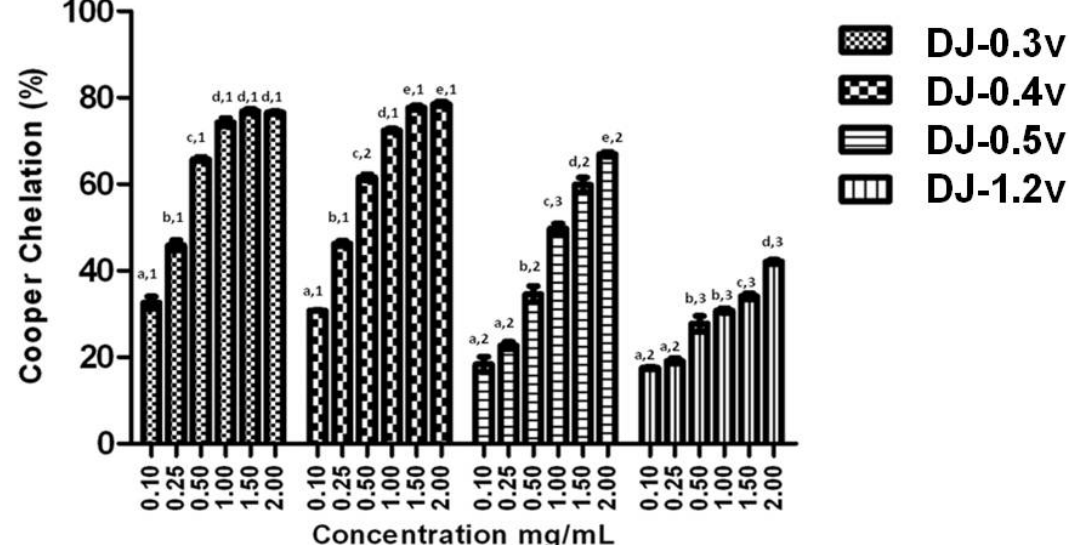
Figure 3. Copper chelating activity of sulfated polysaccharides from the brown algae (seaweed) D. justii . Each value is the mean ± standard deviation of three determinations: Different letters ( a , b , c , d , e ) indicate a significant difference ( p < 0.05) between each concentration of the same sulfated polysaccharide. Different numbers (1, 2, 3) indicate a significant difference ( p < 0.05) between the same concentrations of different sulfated